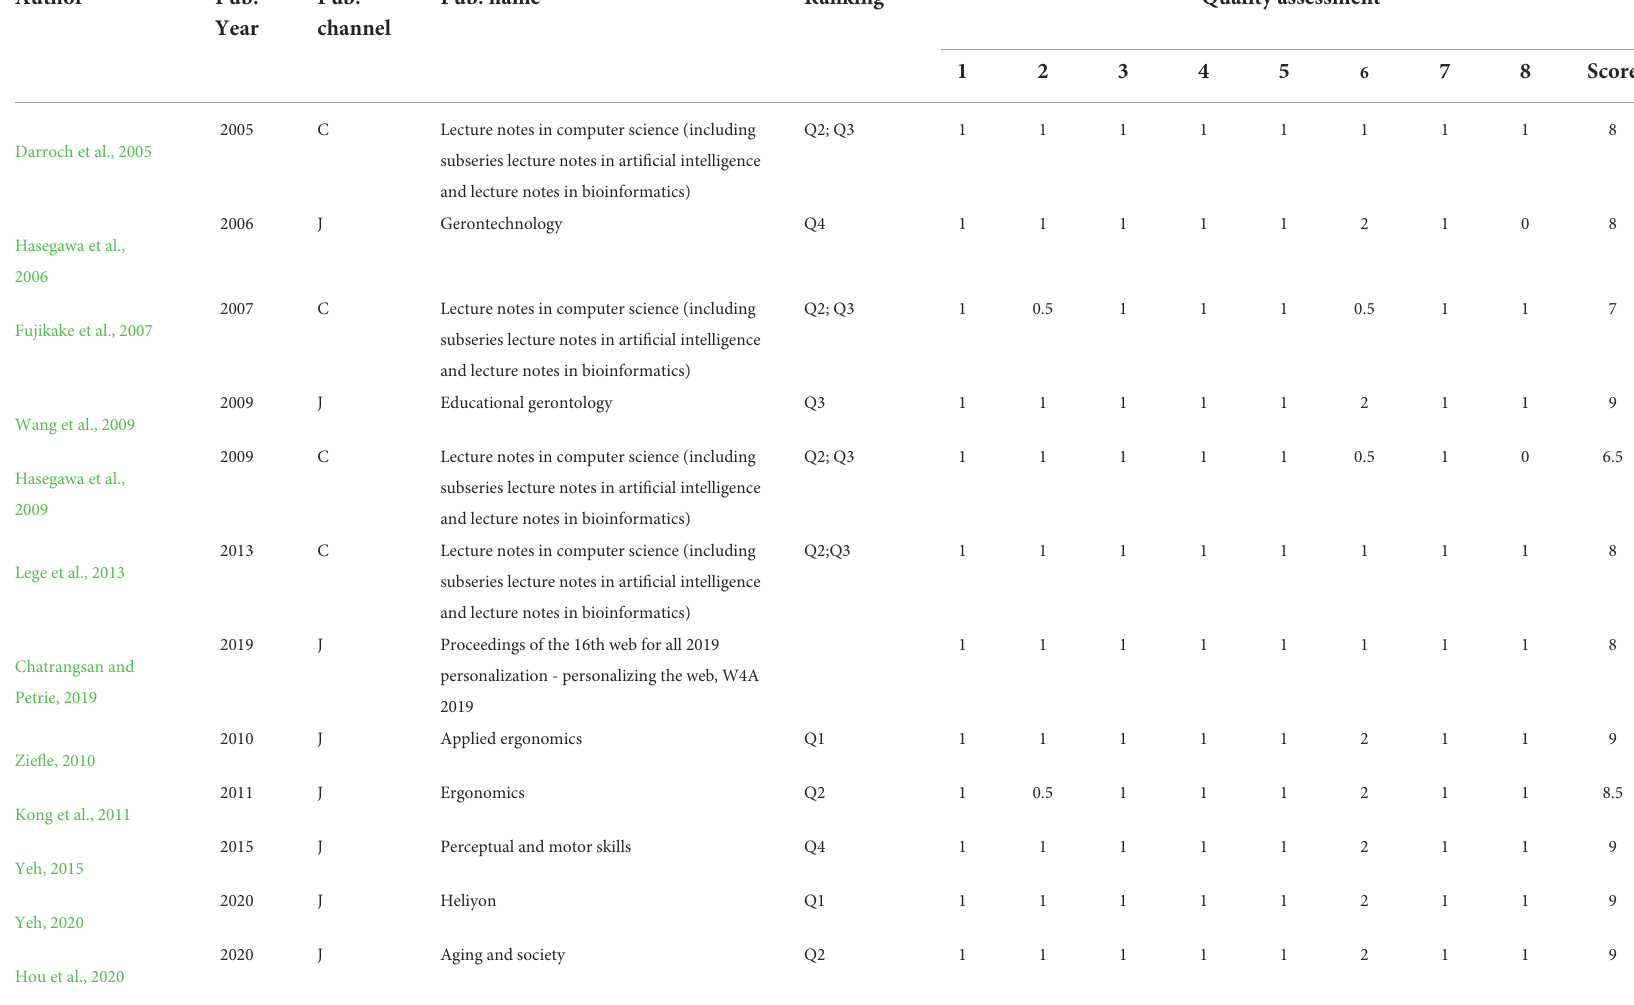
TABLE 6 Papers selected and quality assessment